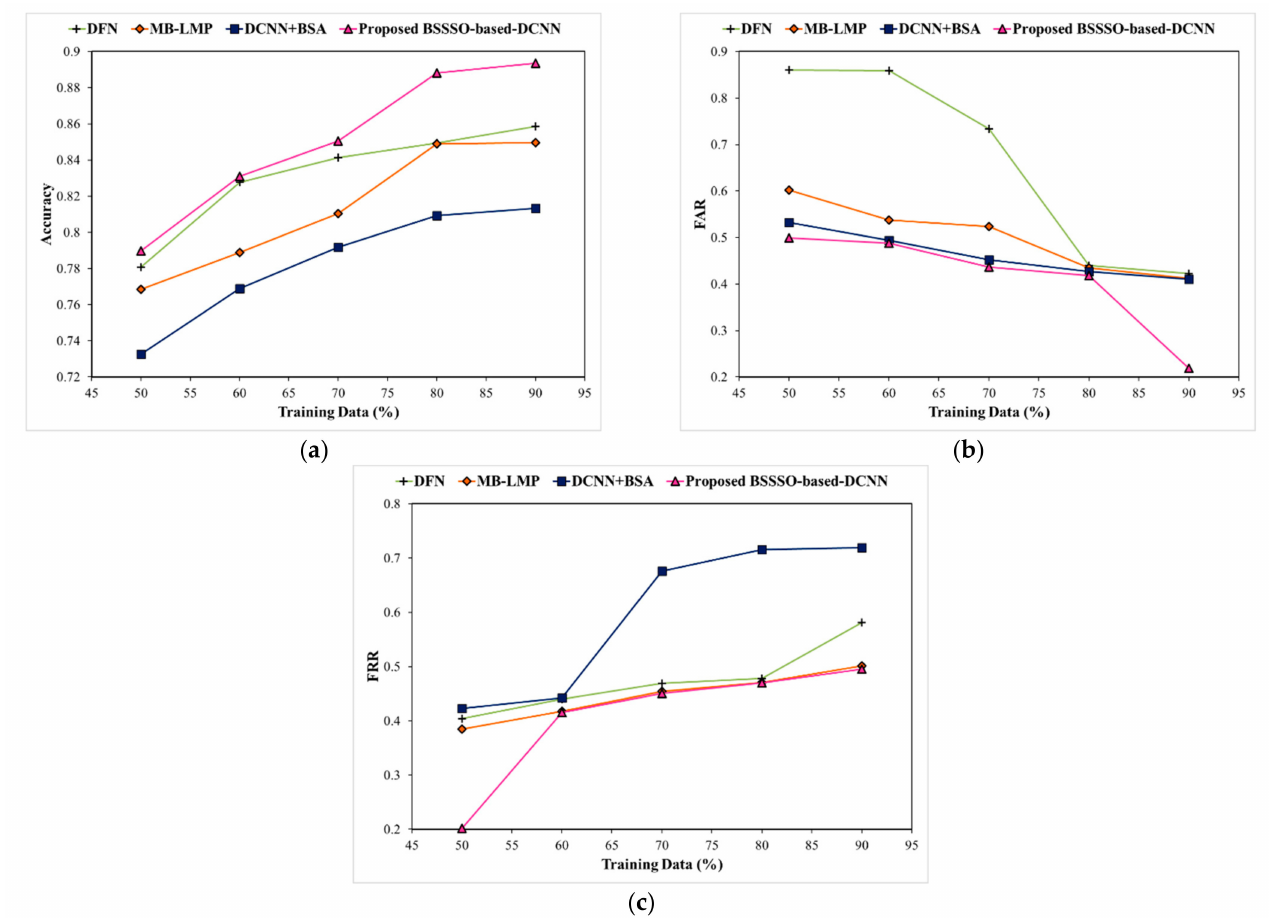
Figure 7. Analysis based on LFW database based on training